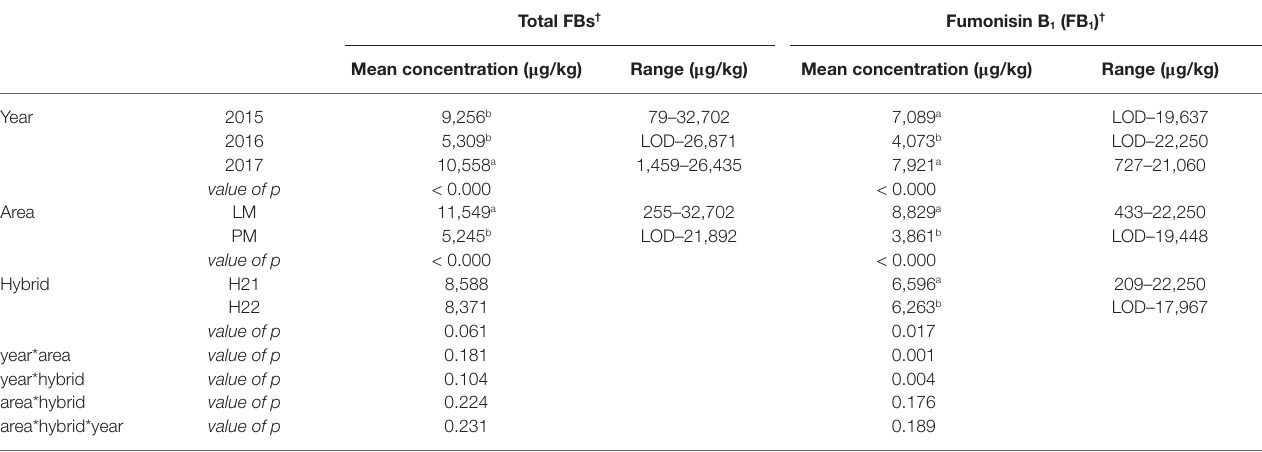
TABLE 1 | Multi-factor ANOVA (MANOVA) analysis performed on fumonisin accumulation in hybrid maize samples grown in different geographical regions over 3 years (full dataset, N TOT = 252).